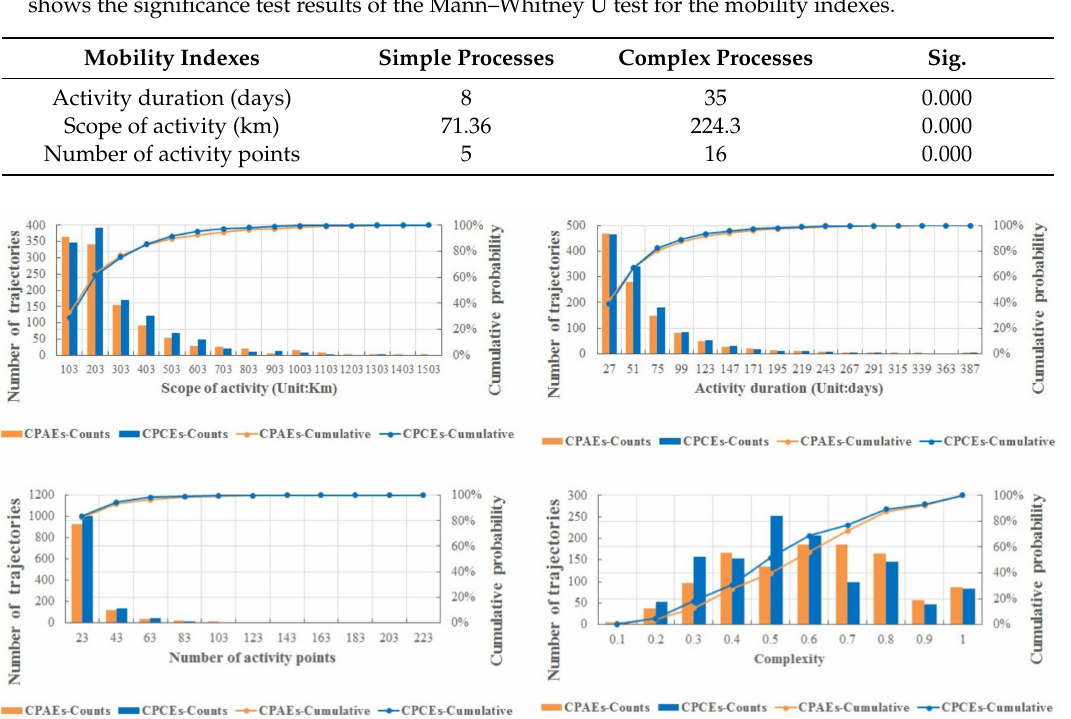
Table 1. Comparison of the means between the simple and complex eddy processes. The last column shows the significance test results of the Mann–Whitney U test for the mobility indexes.